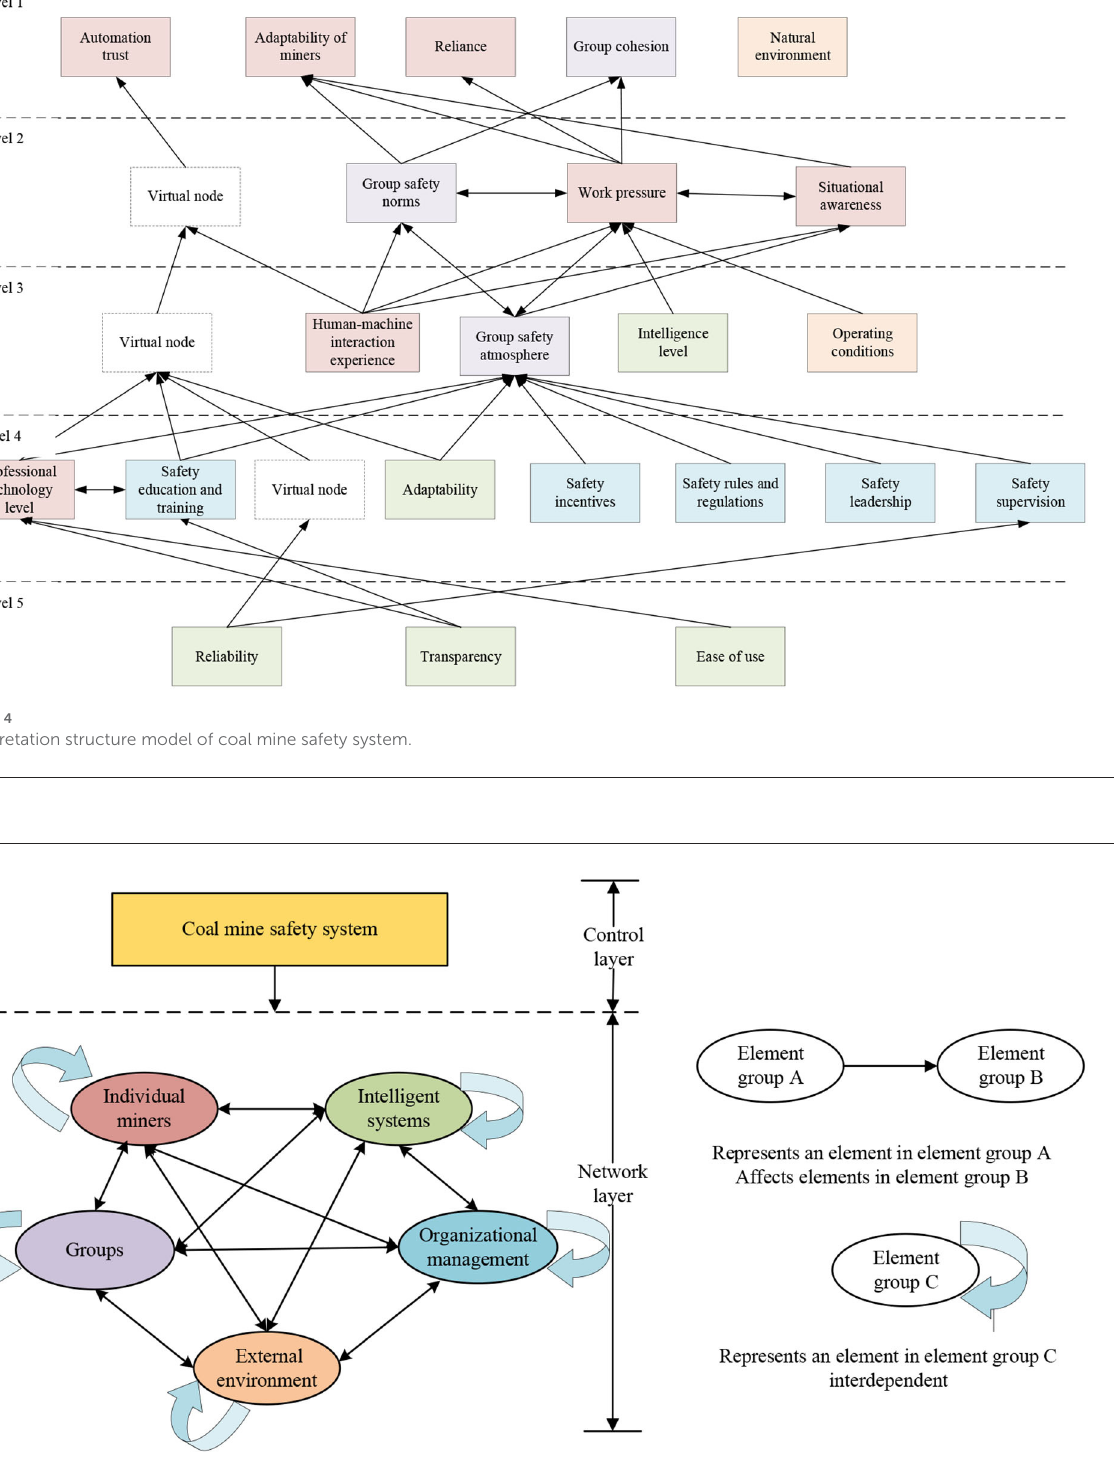
FIGURE5 Network structure model of coal mine